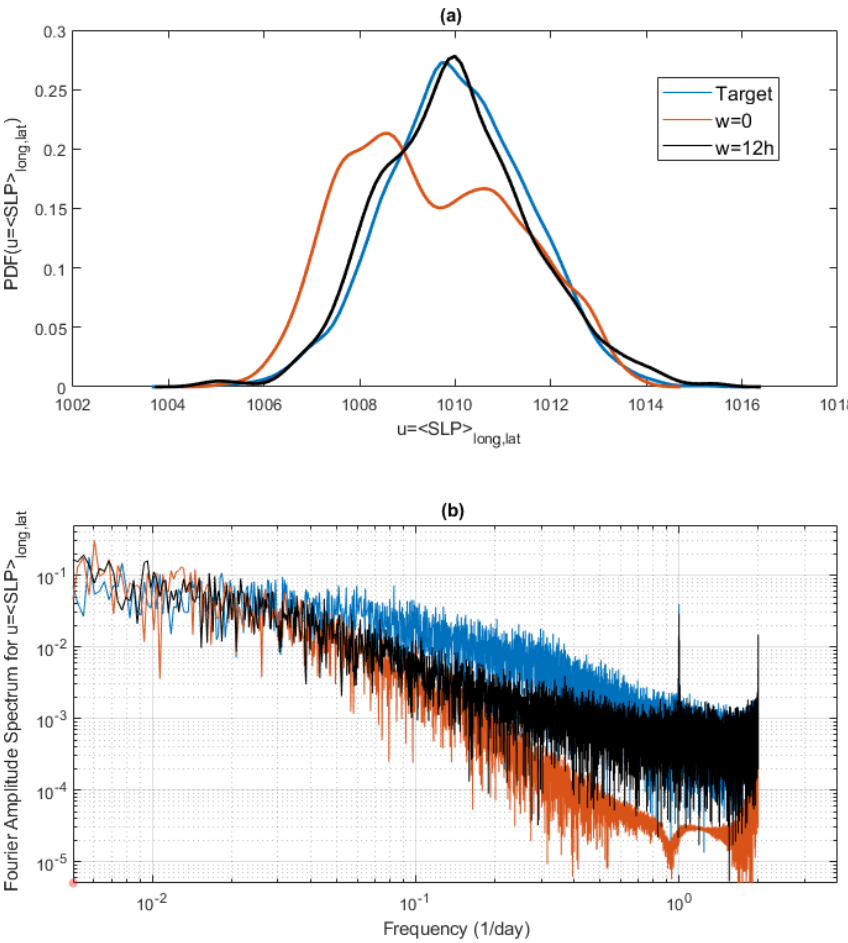
Figure 10. (a) Probability density function and (b) Fourier power spectra for u(t) ≡ (cid:104) SLP (t) (cid:105) lon , lat for the target NCEPv2 SLP data (blue), an ESN with c = 4 and w = 0h (red), and an ESN with c = 4 and w = 12h